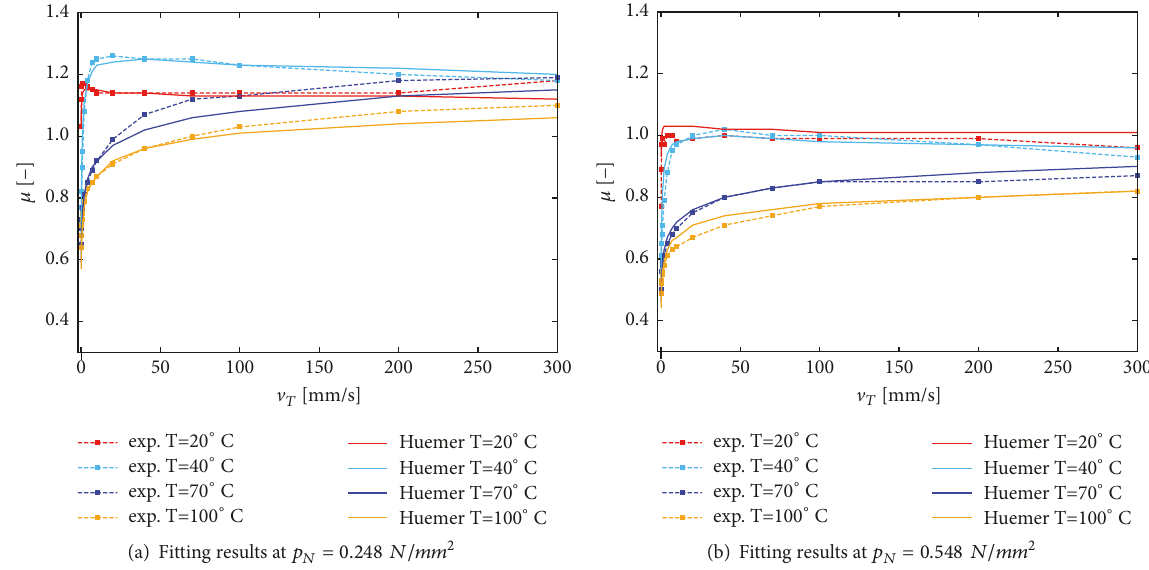
Figure 5: Friction coefficient 𝜇 provided by the Huemer friction law versus experimental result at normal pressure 𝑝 𝑁 = 0.248 𝑁/𝑚𝑚 2 and 𝑝 = 0.548 𝑁/𝑚𝑚 2 and at various temperatures. 𝑁